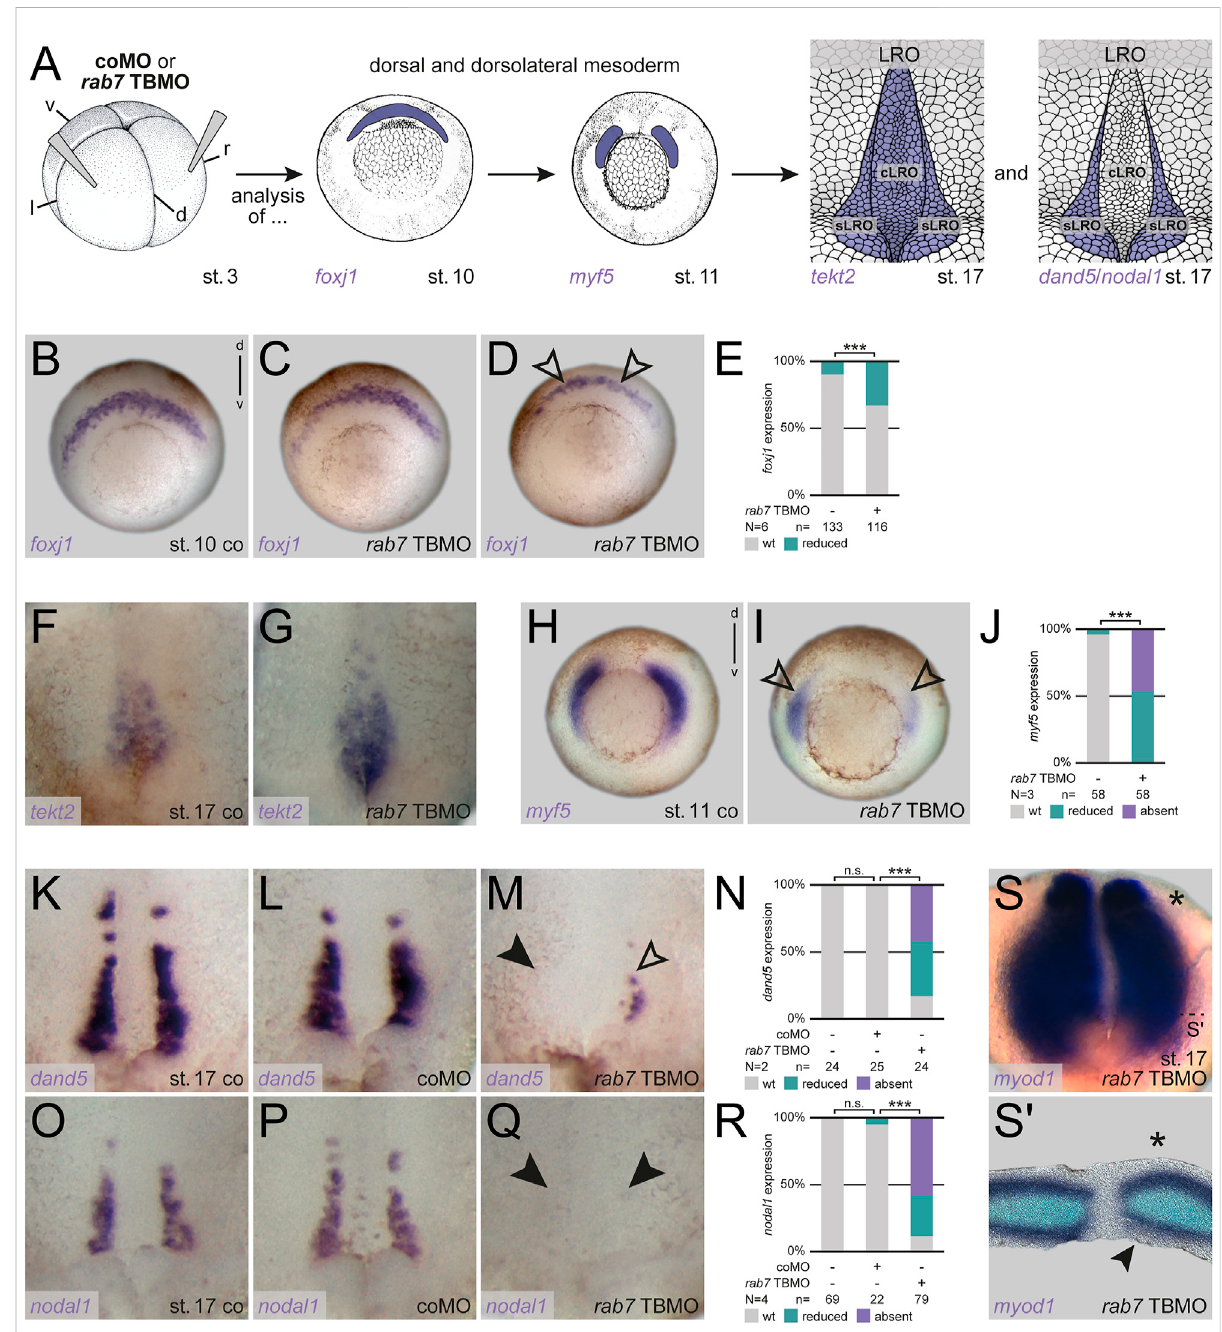
FIGURE 2 Rab7 knockdown resulted in loss LRO sensor tissue. (A) Experimental setup for the shown experiments: Injections at four-cell stage (left) targeted the dorsal/dorsolateral mesoderm to analyze super fi cial mesoderm induction ( foxj1 ; middle) or somitic mesoderm speci fi cation ( myf5 ; middle) at gastrula stages, following analyses of general LRO formation ( tekt2 ; right) or sLRO speci fi cation ( dand5 / nodal1 ; right) during neurulation. (B) Wild type crescentic foxj1 transcripts were (C) unaltered or (D) mildly affected by low dose rab7 TBMO injections (black outlined arrowheads). (E) Quanti fi cation of foxj1 expression. (F) Expression domain of tekt2 in the LRO of st. 17 embryos, (G) depicted slightly stronger posterior and reduced anterior signals upon low dose rab7 TBMO treatment. (H) Wild type dorsolateral myf5 expression (I) was signi fi cantly reduced in rab7 -morphant embryos (black outlined arrowheads). (J) Quanti fi cation of myf5 expression. (K,O) Expression of dand5 and nodal1 in the somitic domains of the LRO of control and (L,P) coMO injected specimen, respectively. (M) Transcripts of dand5 or (Q) nodal1 were lost (black arrowheads) or severely reduced (black outlined arrowheads) in rab7 -de fi cient embryos (low dose TBMO). (N,R) Quanti fi cation of dand5 and nodal1 expression, respectively. (S) Left-sided unilateral knockdown (marked by asterisk) of low dose rab7 TBMO in myod1 expressing LRO, (S 9 ) section revealed lost super fi cialexpressionof myod1 atinjectionside(blackarrowhead).cLRO,centralLRO;co,control;coMO,controlMorpholinooligomere;d,dorsal;l, left; LRO, left-right organizer; N,numberof experiments; n, number ofevaluated embryos; n.s.,not signi fi cant; r,right;sLRO,somitic LRO;st., stage; TBMO, translation blocking Morpholino oligomere; v, ventral; wt, wild